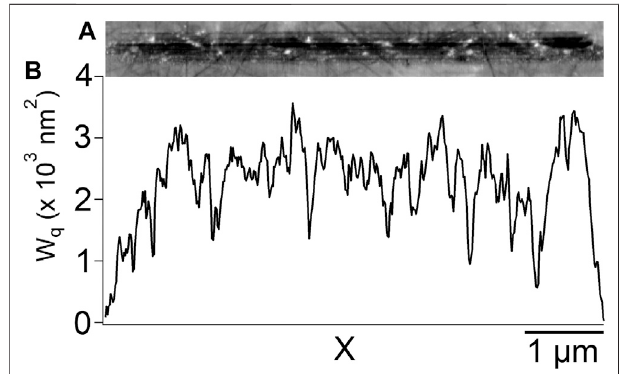
FIGURE 10 | (A) A scar obtained with particle No. 4 ( N (cid:1) 5,120, F N (cid:1) 0.78 µN, and sF N (cid:1) 0.04 μ Nm) with several wear particles adhering onto the scar surface. The Z -scale is ± 10 nm (B) Planimetric wear W q (cross-sectional area of the track) vs. X position. Negative peaks of W q correspond to wear